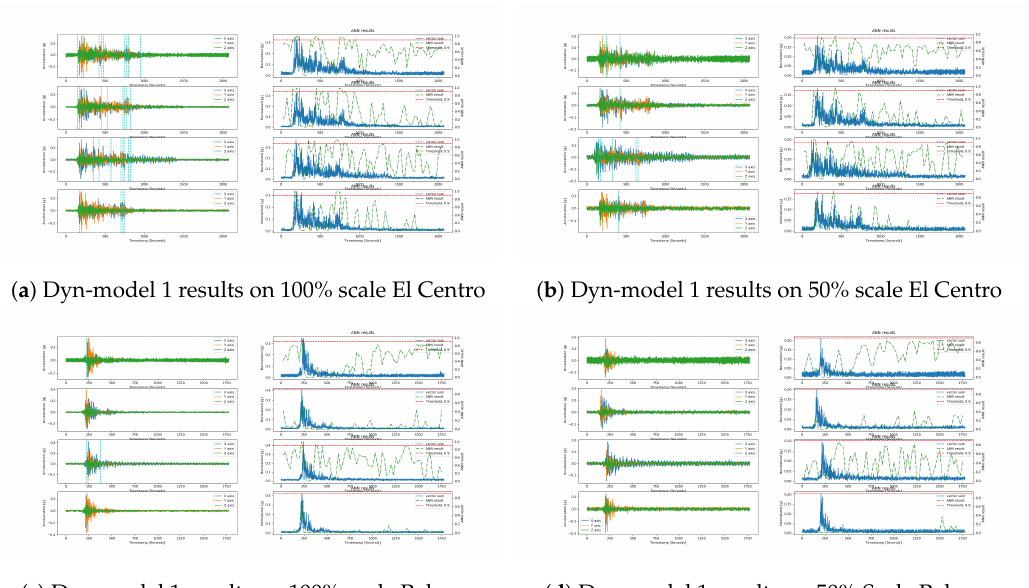
Figure 12. Dyn-model 1 test results on the El Centro earthquake of scale 100% (left-top) and scale 50% (right-top); Model test results on the Pohang earthquake of scale 100% (left-bottom) and scale 50% (right-bottom); the results are ordered from top to bottom for each subfigure’s sensor, namely ADXL355, LIS3DHH, MMA8452, and